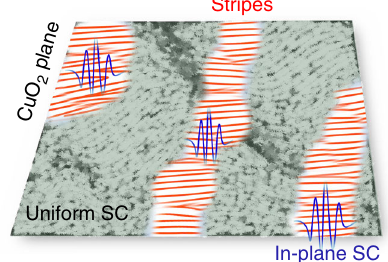
Fig. 5 Inhomogeneous electronic orders in LSCO. Artistic illustration of the stripe-ordered CuO 2 plane in LSCO. The green colored area denotes the uniform SC state. The distorted big-waves illustration indicates the weakened CDW-SRO. Red colored pattern illustrates the stripe orders. The blue modulations formed around the stripe-ordered areas depict